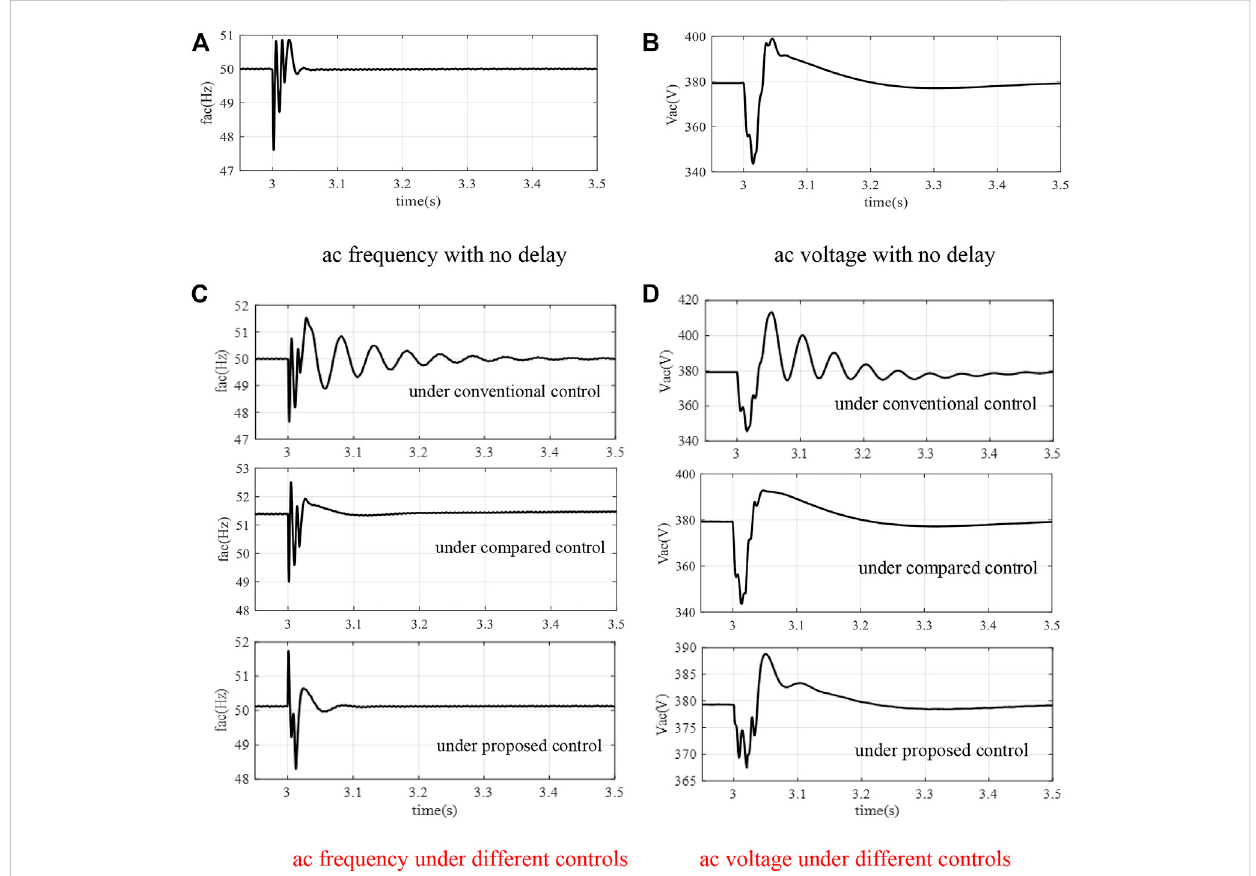
FIGURE 11 The simulation results with 10 ms delay of case 2. (A) ac frequency with no delay, (B) ac voltage with no delay, (C) ac frequency under different controls, (D) ac voltage under different